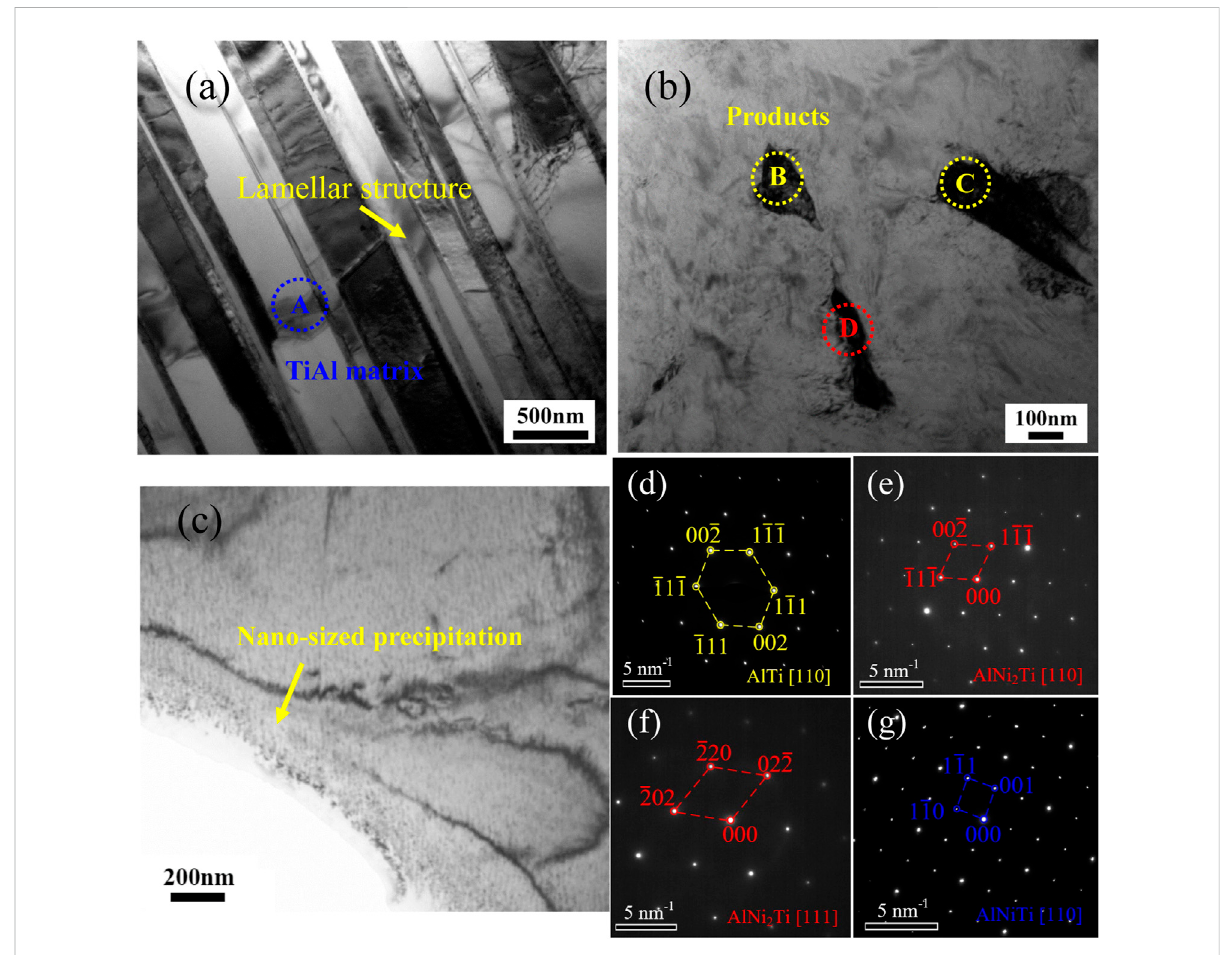
FIGURE 8 TEM image and corresponding SAED pattern: (A) TiAl matrix, (B) intermediate layer, (C) Nano-sized precipitation, (D) SAED pattern of region A marked in panel (A) , (E – G) SAED pattern of region B, C and D marked in panel (B)